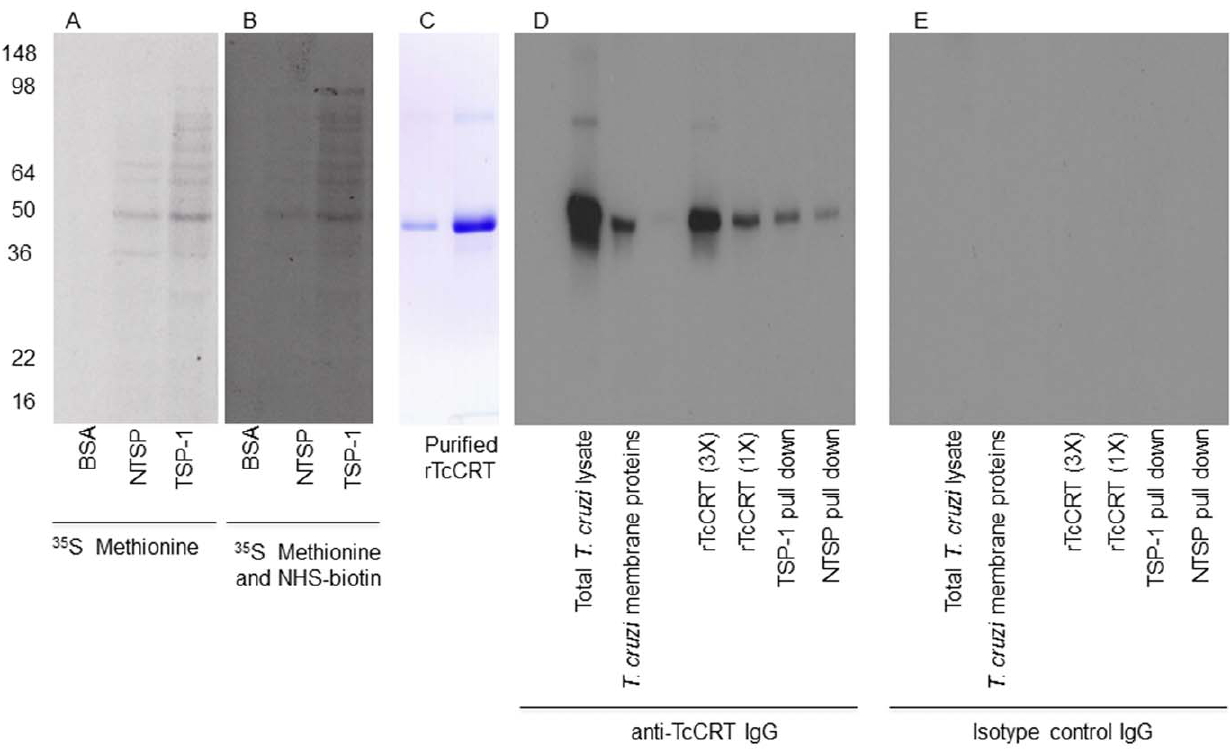
Figure 2. TSP-1 or NTSP pulls down surface TcCRT. 2A , TSP-1 or NTSP pulls down a metabolically labeled T. cruzi 48 kDa protein whereas BSA control does not. Extracted 35 S-methionine labeled trypomastigote membrane fraction was incubated with NTSP, TSP-1 or BSA coated Dynabeads to pull down interacting proteins. The Pull downs were separated by SDS polyacrylamide gels, transferred onto nitrocellulose (NC) membranes and developed by autoradiography. 2B , NTSP or TSP-1 pulls down double labeled T. cruzi 48 kDa surface protein whereas BSA control does not. Extracted 35 S-methionine and NHS-biotin double labeled surface proteins of T. cruzi interacting with NTSP, TSP-1 or BSA coated Dynabeads were recruited with streptavidin Dynabeads, separated by SDS polyacrylamide gel, transferred onto NC membranes and developed by autoradiography. 2C , Purification of rTcCRT. Coommassie blue stain of two eluted fractions of affinity purified His-tagged rTcCRT. 2D , TSP-1 or NTSP pulls down a TcCRT as evidenced by immunoblotting using anti-TcCRT IgG. 2E , Blot of figure 2D was stripped and reprobed with an isotype control antibody. This figure shows the results from a representative experiment of three independent experiments performed with similar results.